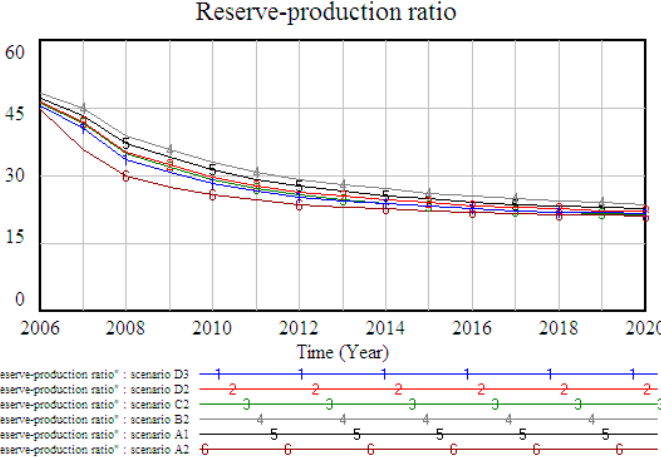
Figure 13. Reserve/production ratio.